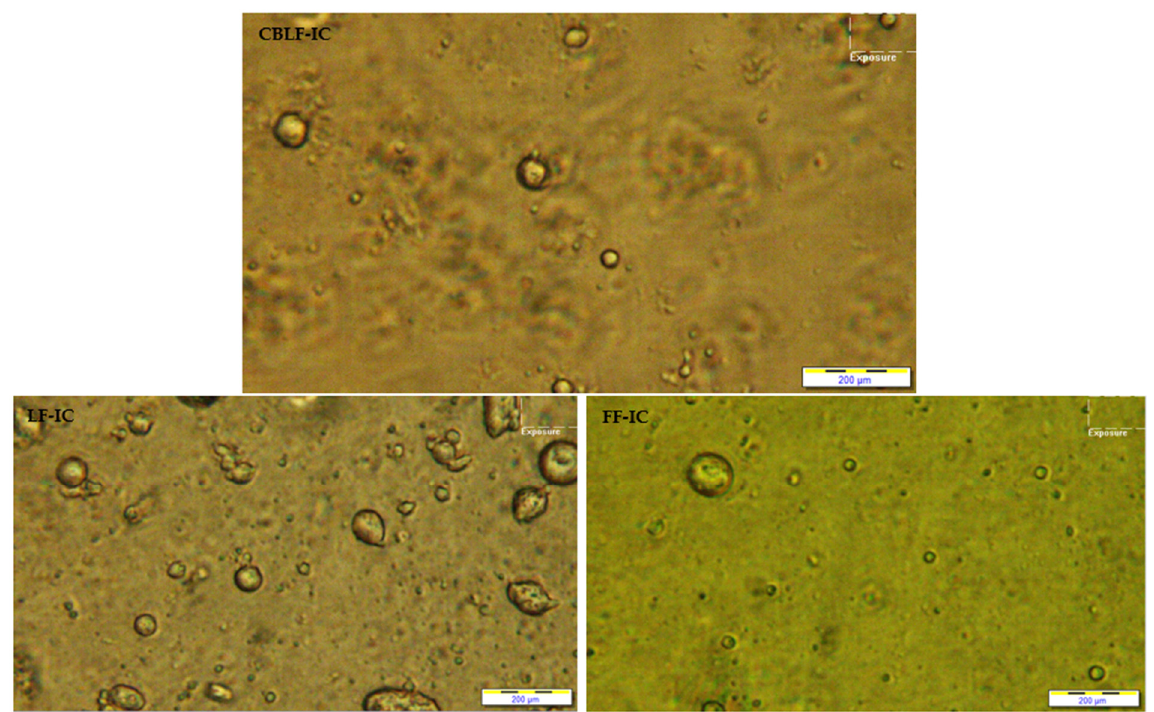
Figure 7. Light microscopy pictures of the ice cream mixtures. FF-IC: full-fat ice cream, LF-IC: low-fat ice cream, CBLF-IC: low-fat ice cream with chia seed oil by-product. Samples were characterized at room temperature at 20 × magnification.